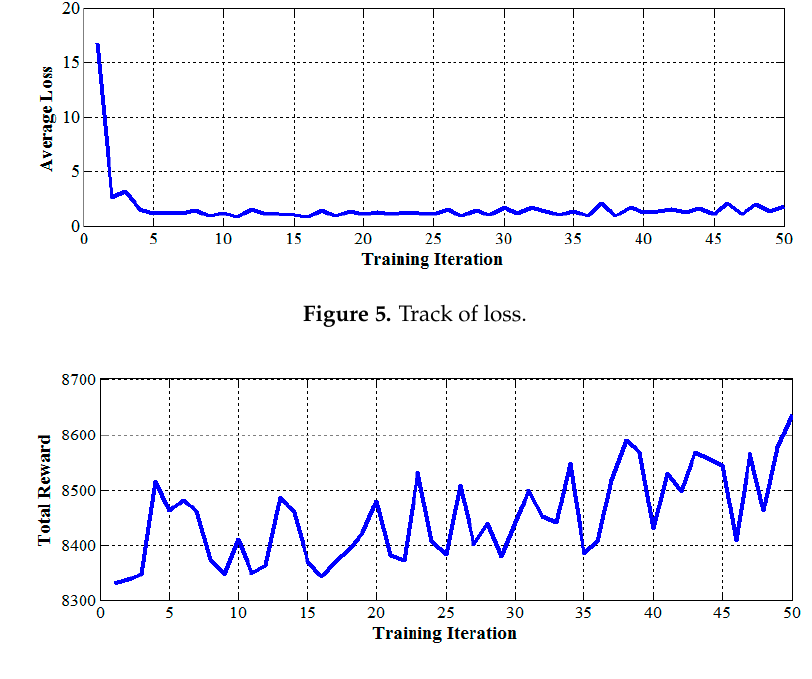
Table 2. Summary of the DRL-based algorithm hyper parameters.